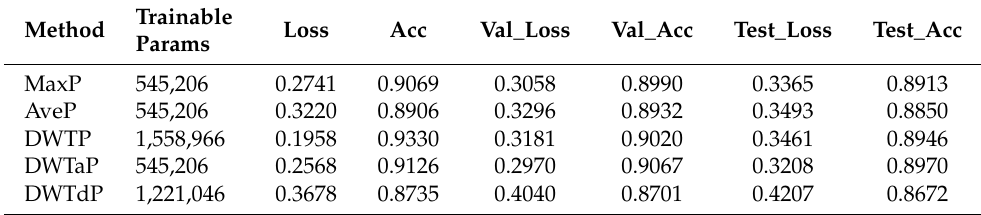
Table 3. Performance of pooling methods on CIFAR-10.